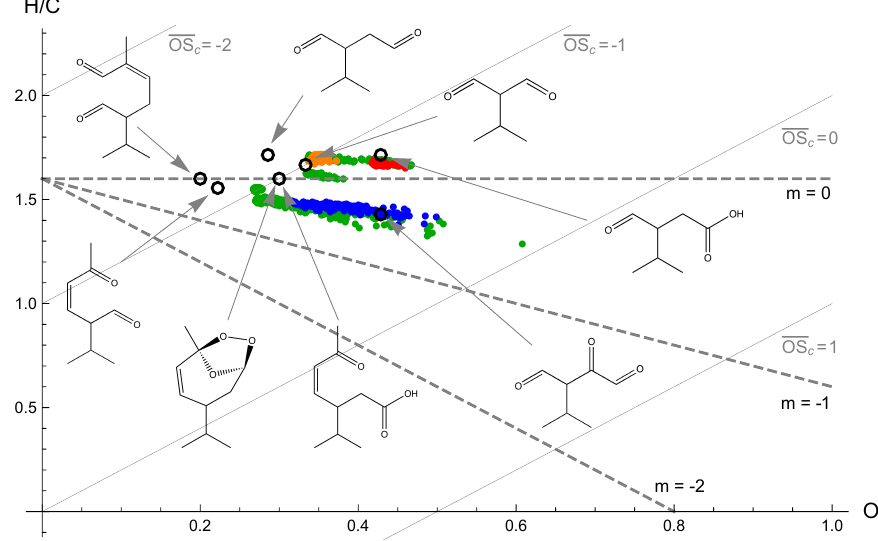
Figure 16. Van Krevelen plot. Blue dots are for experiments with a CI scavenger (6, 7), red dots are for the experiment without cyclohexane (9), yellow dots are for the experiment with NO 2 added (11) and green dots are for the remaining experiments. Both predicted and detected gas-phase species are shown with open black circles.